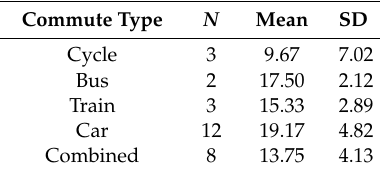
Table 3. Descriptive statistics for PSS score by commute